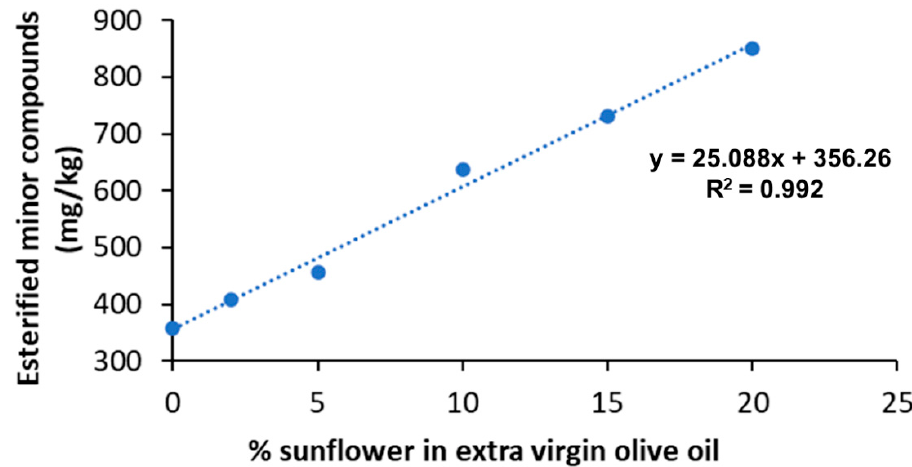
Figure 3. Linearity of esterified minor compounds concentrations in a pure EVOO and its blends with RSO at percentages